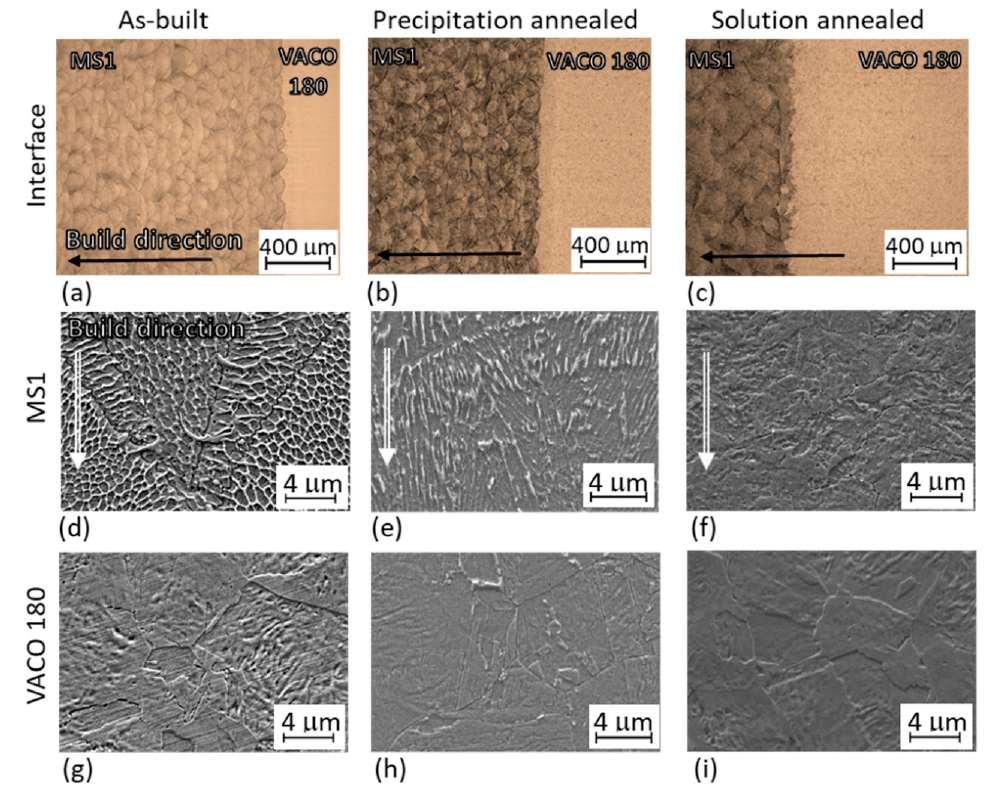
Figure 7. Optical micrographs of the interface: ( a – c ); SEM Micrographs of additively manufactured MS1 steel ( d – f ); the microstructure of VACO 180 ( g – i ). Hybrid parts without post ‐ processing heat treatment ( a , d , g ); with precipitation hardening ( b , e , h ); with solution annealing ( c , f , i ).